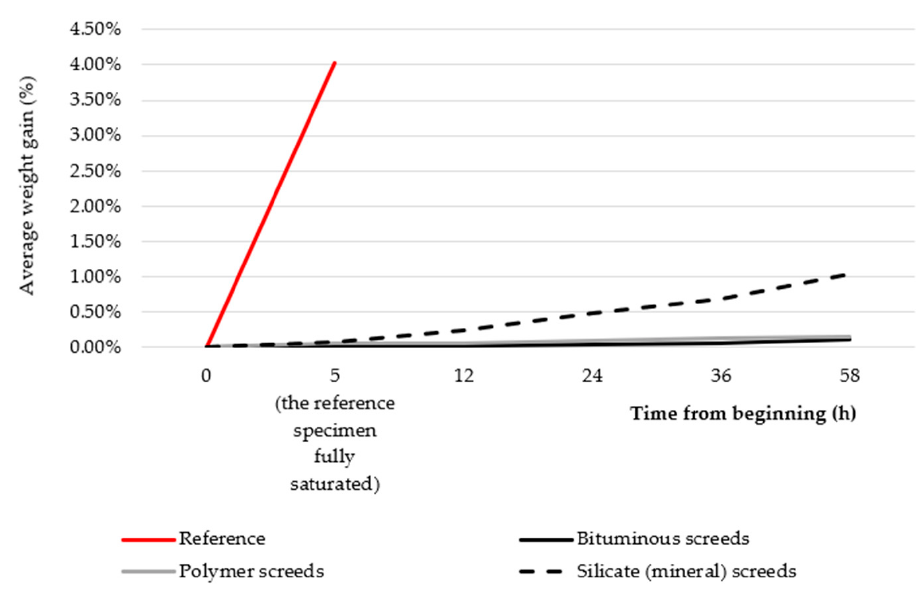
Figure 11. Change in weight during the time (in